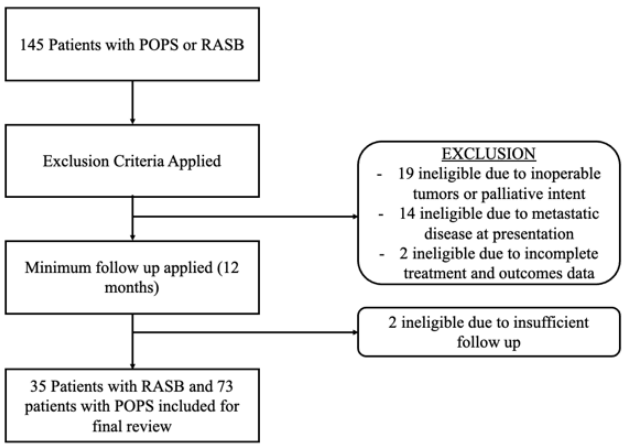
Figure 1. Patient flow chart demonstrating inclusion and exclusion criteria for patients with radiation-associated sarcoma of the pelvis and sacrum and those with primary osteosarcoma or spindle cell sarcoma.